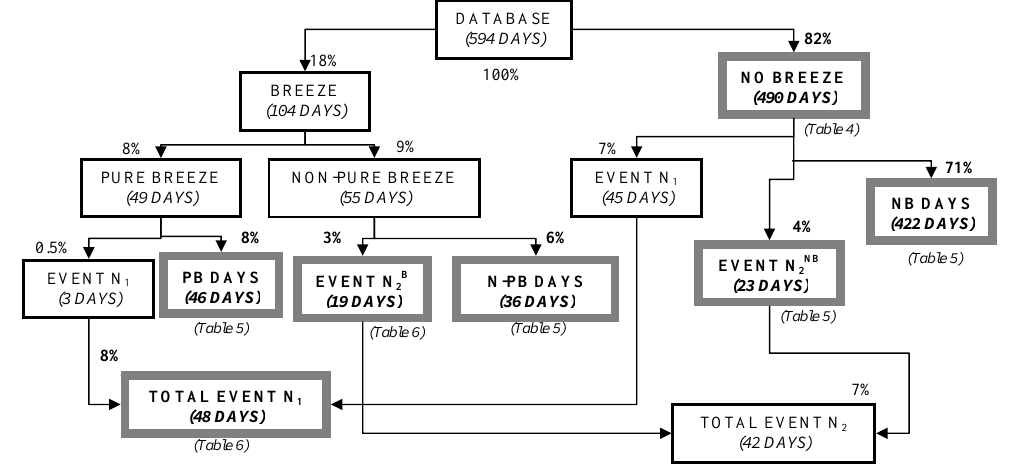
Fig. 6. Representative days’ segregation by means of sea-land breezes (pure and non-pure) days and nucleation events ( N 1 and N 2 ) . Tables containing the modal parameters of the median size distribution function for each classification are also indicated.